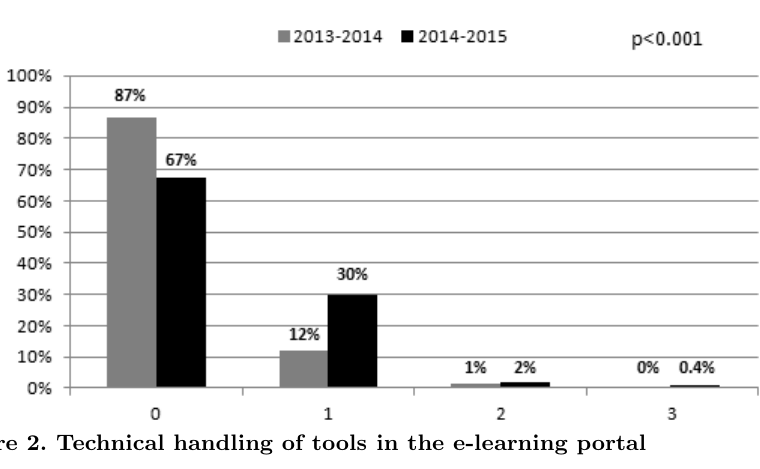
Figure 1. Usefulness of e-learning portal tools